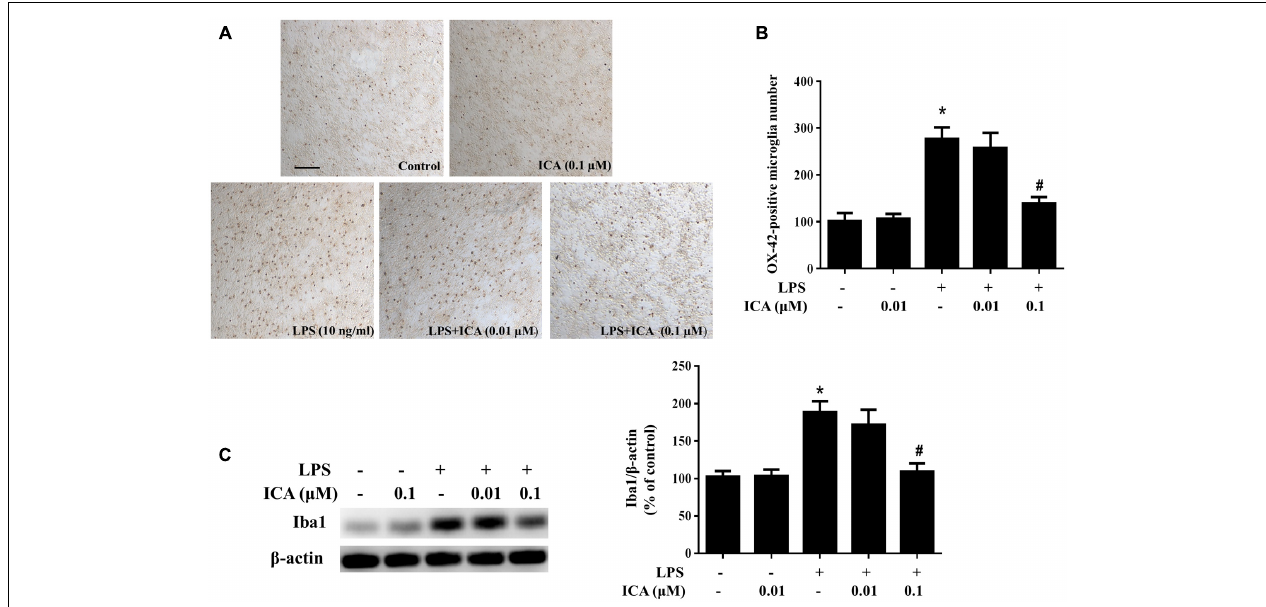
FIGURE 3 | Icariin ameliorated LPS-induced microglial activation in vitro. Rat primary midbrain neuron-glia cultures were treated with ICA (0.01 and 0.1 µ M) for 30 min and then stimulated by LPS (10 ng/ml). Seven days later, the activated microglia were detected by immunocytochemical staining with anti-OX-42 antibody. Representative images of immunostaining from three experiments were indicated (A) . Scale bar: 100 µ m. The quantification of OX-42-positive microglia was performed (B) . The level of Iba1 protein expression in the neuron-glia co-cultures was detected via western blot assay (C) . The ratio of densitometry values of Iba1 with β -actin was assessed and normalized to each respective control group. Results were the mean ± SEM from three independent experiments performed in triplicate. ∗ p < 0.05 compared with the control cultures; # p < 0.05 compared with LPS-treated